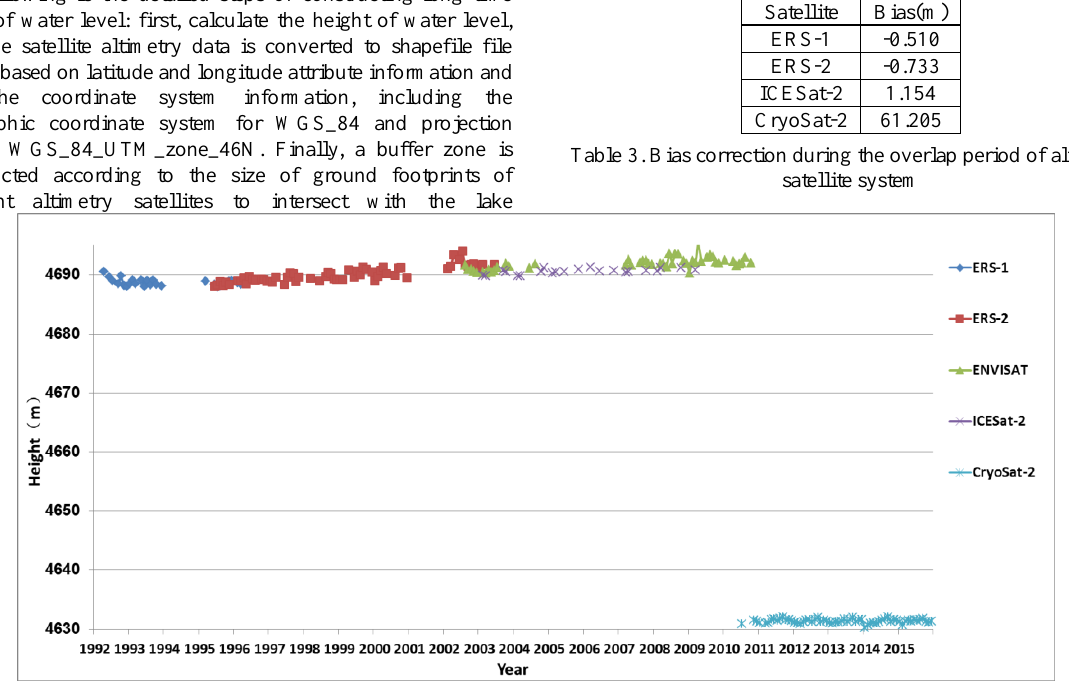
Figure 3. Multi-mission radar altimetry results before eliminating the systematic bias